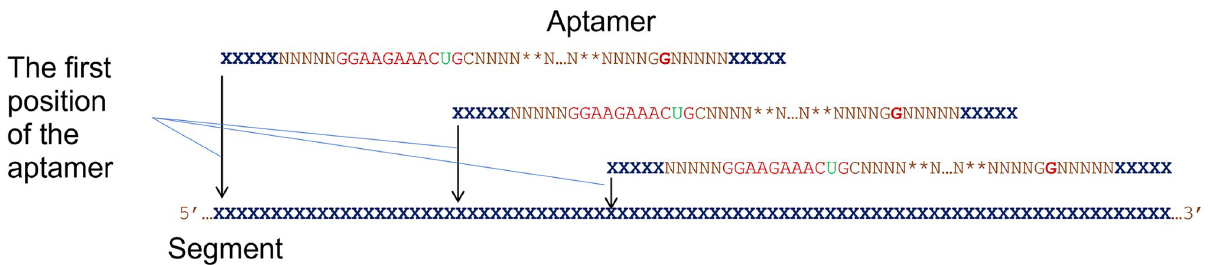
Fig 6. Idea of the search for a domain/motif within the range from 1 to W positions (in the window) instead of an only predetermined position. The first position is shifted by w = 1 ... W nucleotides, where W is not too large (100–200).